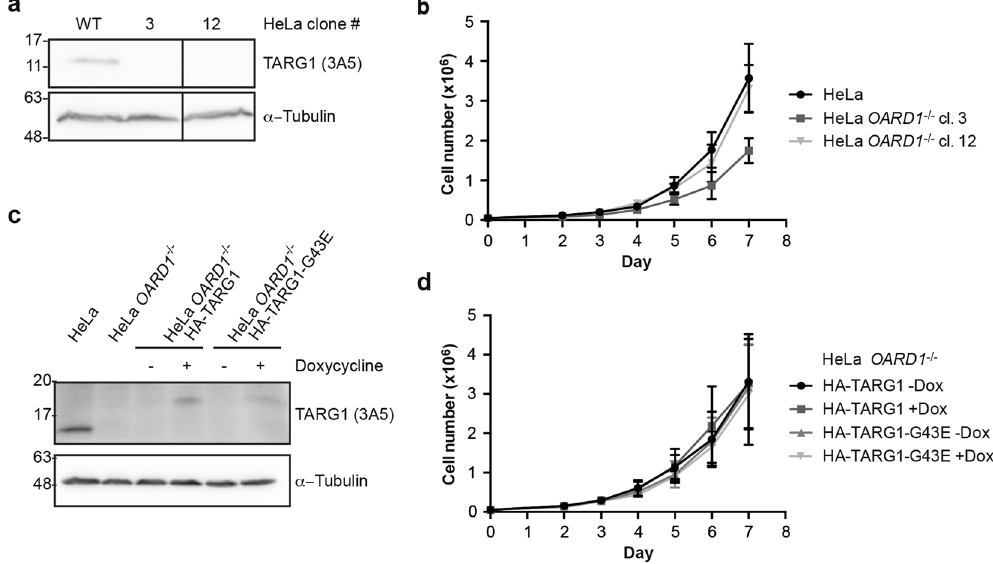
Figure 2. OARD1 knock-out does not affect cell proliferation of HeLa cells. ( a ) TARG1 expression was analyzed in whole cell lysates of HeLa cells (WT) and the HeLa OARD1 − / − clones 3 and 12 by Western blotting using the TARG1-specific monoclonal antibody 3A5. α -Tubulin was detected as loading control. ( b ) Cell proliferation of HeLa cells and HeLa OARD1 − / − clones 3 and 12 was measured by counting living cells over 7 days. ( c ) HeLa OARD1 − / − (cl. 3) cells were stably transduced using a lentiviral vector allowing for doxycycline-inducible re- expression of HA-TARG1 or HA-TARG1-G43E. TARG1 protein expression was analyzed in HeLa OARD1 − / − HA-TARG1 wildtype or -G43E cells that were treated with 100 ng/ml doxycycline or were left untreated for 48 h by Western blotting. α -Tubulin levels were detected as a loading control. ( d ) Cell proliferation of HeLa OARD1 − / − HA-TARG1 or HA-TARG1-G43E cells, which were treated with 100 ng/ml doxycycline every 48–72 h or were left untreated ( ± Dox), was measured over 7 days by counting living cells. ( a and c ) Full-length blots are presented in Supplementary Fig.